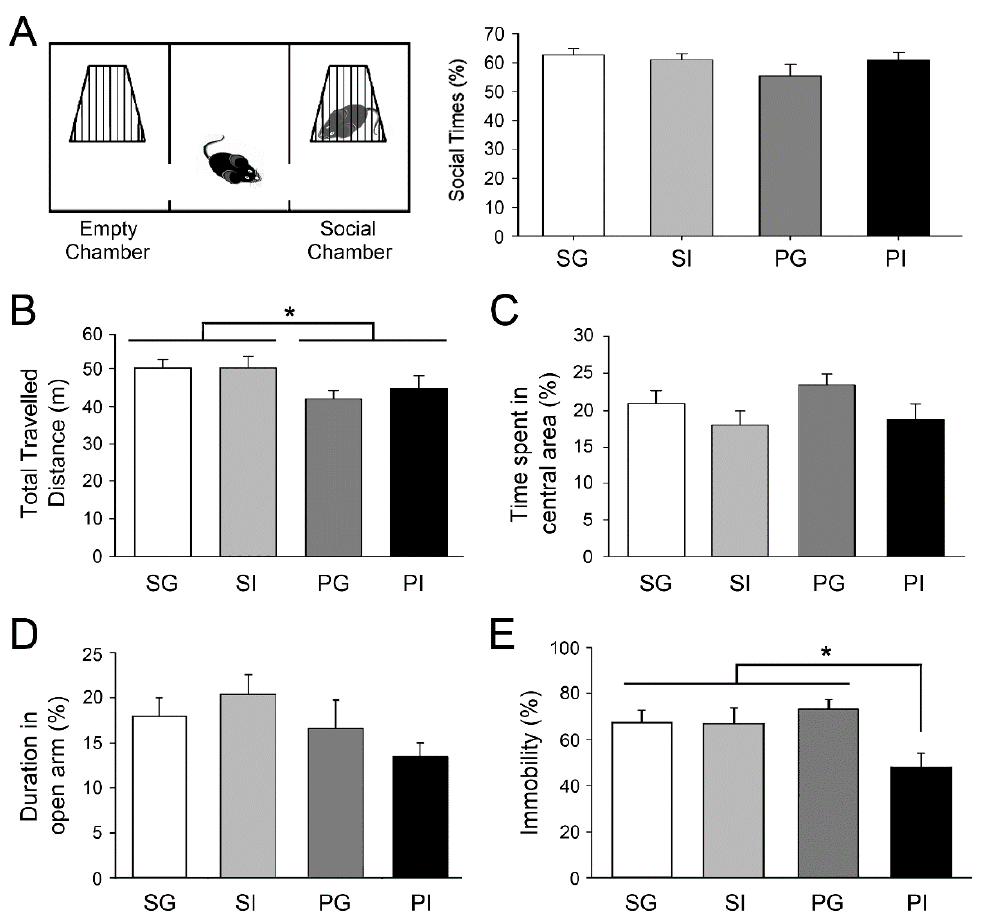
Figure 2. Examinations of social, locomotive and emotional behaviors. ( A ) Social behaviors were examined in a three-chamber test. ( B , C ) Locomotor activity of mice was examined in a novel open field. ( D ) The extent of anxiety was estimated in an elevated plus maze. ( E ) The degree of depression was evaluated by measuring the time spent in immobility in a forced swim test. Results are mean ± SEM ( n = 8–12 per group). * p < 0.05.